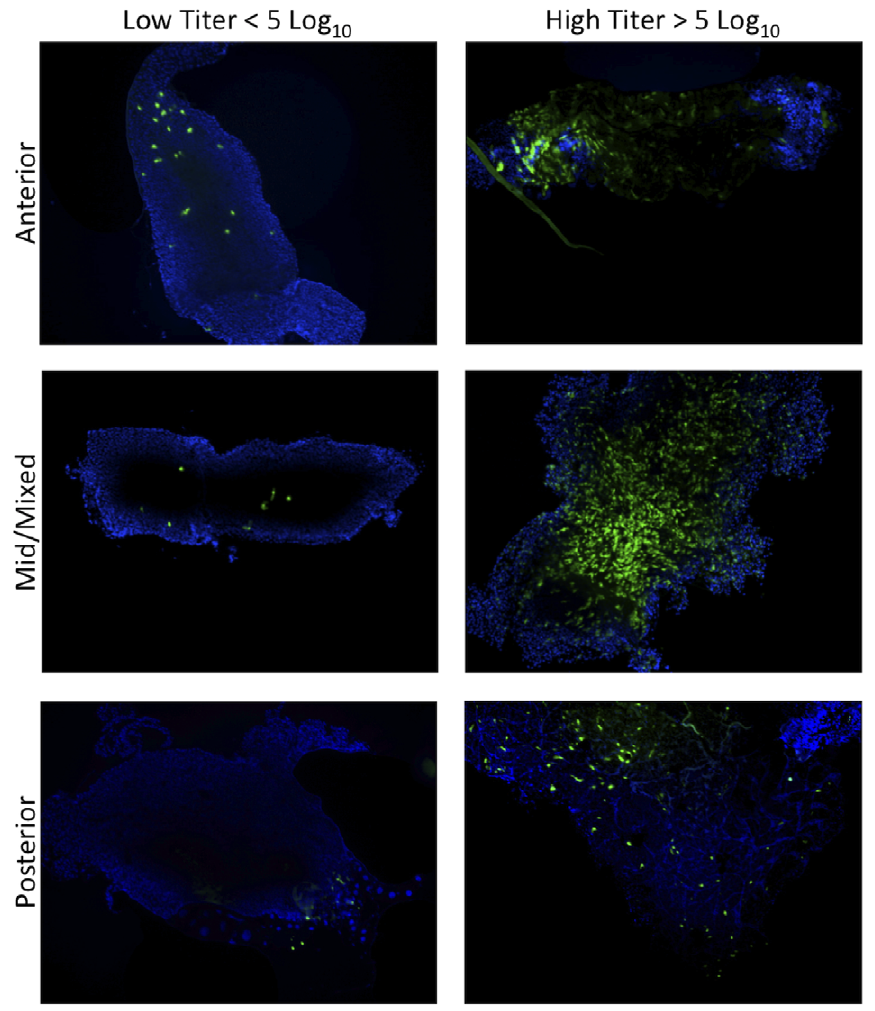
Figure 5. Sites of 68UGFP midgut infection in C.taeniopus (10 6 ). Replicons were observed to infect the anterior, mid, and posterior portions of the abdominal midgut at all doses of